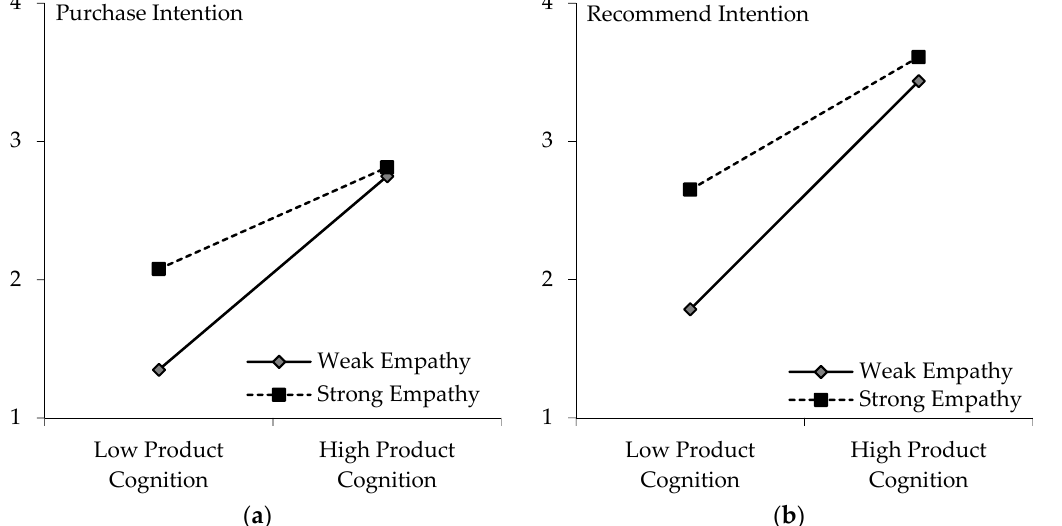
Figure 3. Effect of Empathy on Product Cognition Affecting Consumers’ Behavioral Intentions.